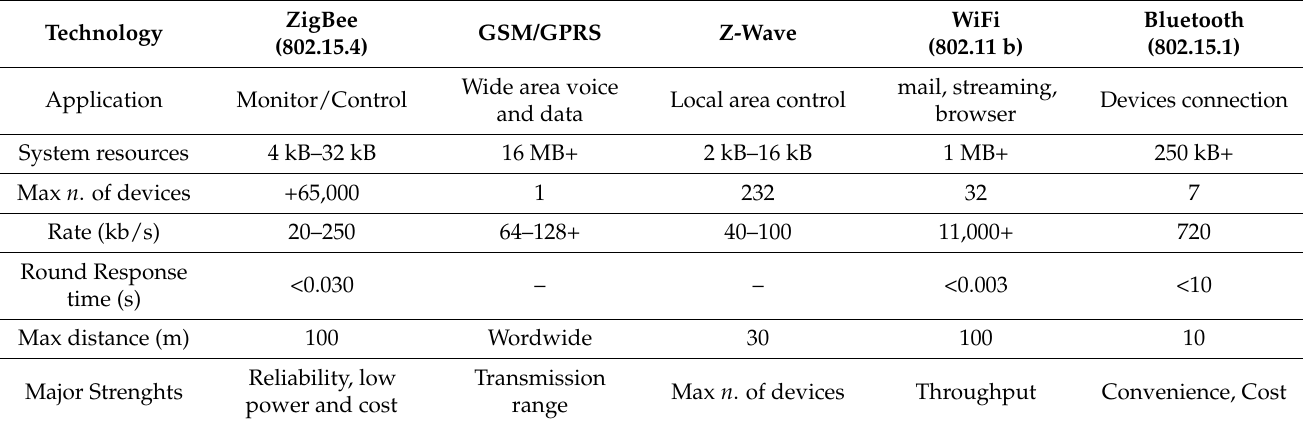
Table 2. Different wireless technologies.